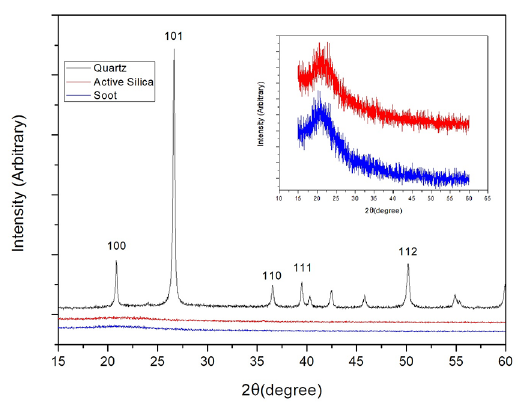
Figure 5. XRD pattern obtained for submicron quartz. The inset shows the soot and the active silica low-intensity crystalline peaks.